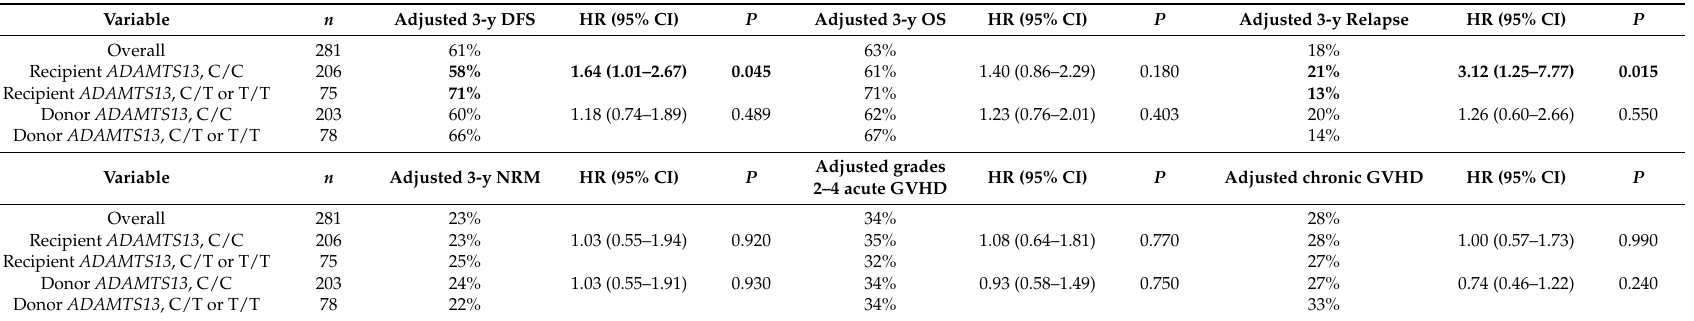
Table 2. The results of a multivariate analysis regarding the association between ADAMTS13 variations and clinical outcomes after transplantation.